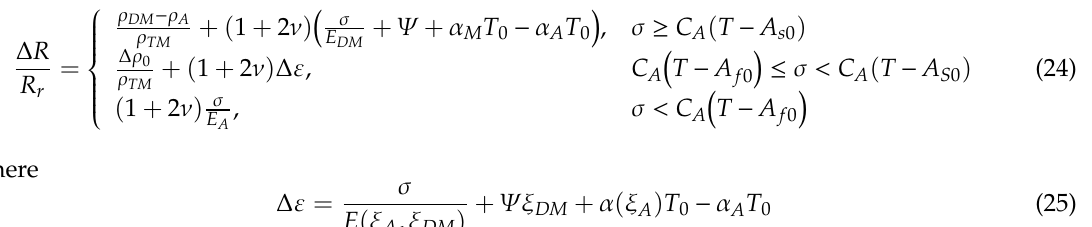
Figure 6. The relationship between σ - ε and σ -Δ R / R at 100 °C.